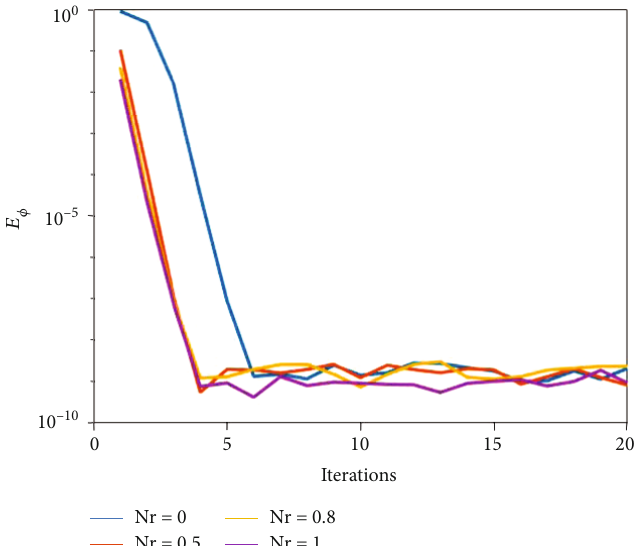
: 8, ξ = 1, N N Df = Sr = Bi = 0 : 5, He b = t = w = 0